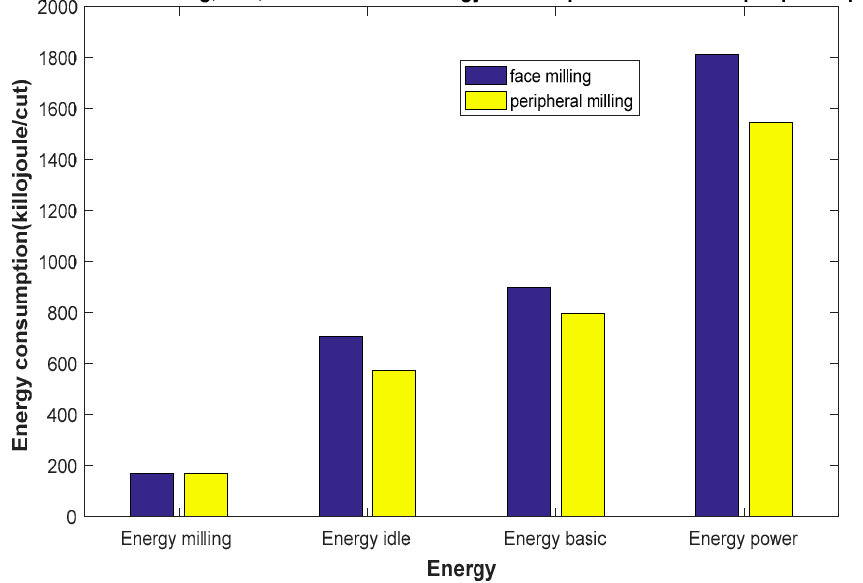
Figure 8. Comparison of milling, idle, basic and total energy consumption for face and peripheral process.